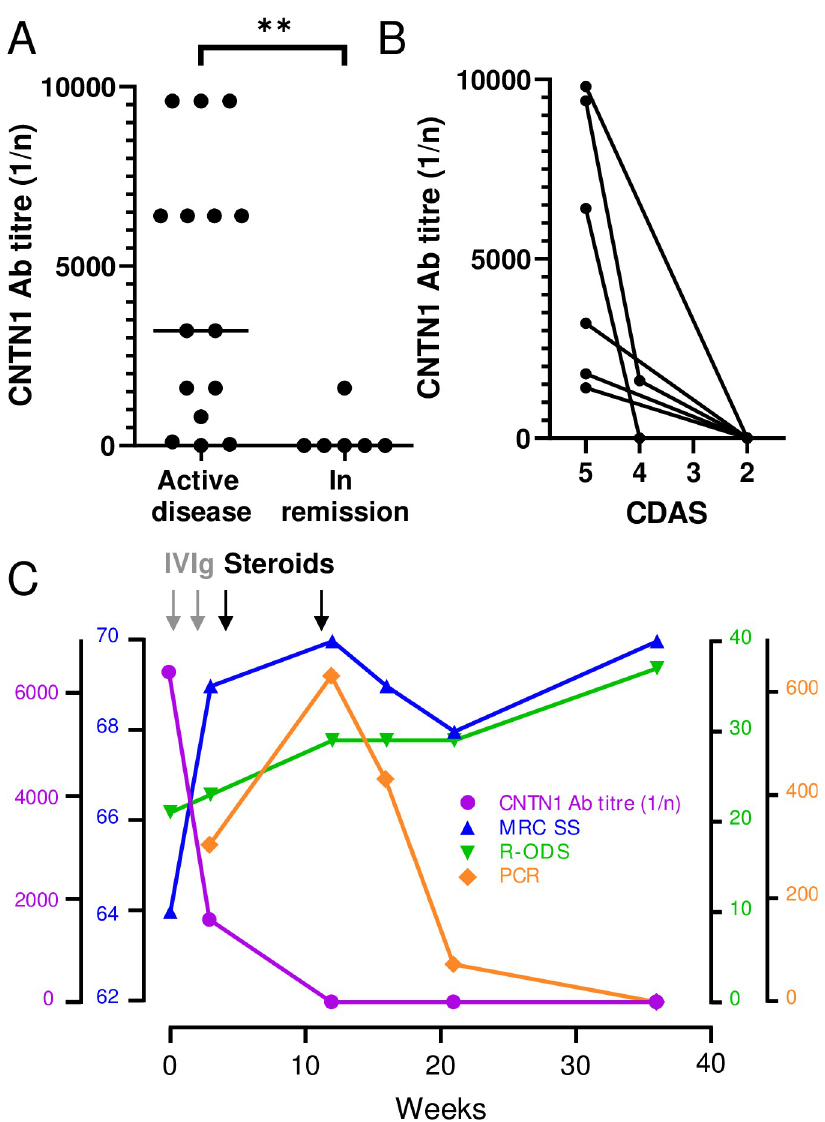
Fig 3. CNTN1 antibody titres correlate with disease activity. A) CNTN1 antibody titres were significantly higher in active disease (on or pre-treatment) (n = 15), compared to remission off treatment) (n = 6, p = 0.001, Mann-Whitney). B) In all 6 patients for whom serial samples were available, CNTN1 antibody titres fell in parallel with a reduction in neuropathy disease activity (measured using the CIDP Disease Activity Scale–CDAS) and became undetectable in 5 patients who achieved treatment-free remission. C) In one patient, where this level of detail was available, serial assessments showed that improvements in strength ( Medical Research Council sum score, MRC-SS), functional abilities (inflammatory neuropathy Rasch-built Overall Disability Scale, iR-ODS) and normalisation of renal function (Protein Creatinine Ratio, PCR) correlated with falling CNTN1 antibody titres. Grey arrows indicate IVIg administration (2g/kg over 5 days), and black arrows pulsed dexamethasone (40mg daily for 4 days, repeated after 4